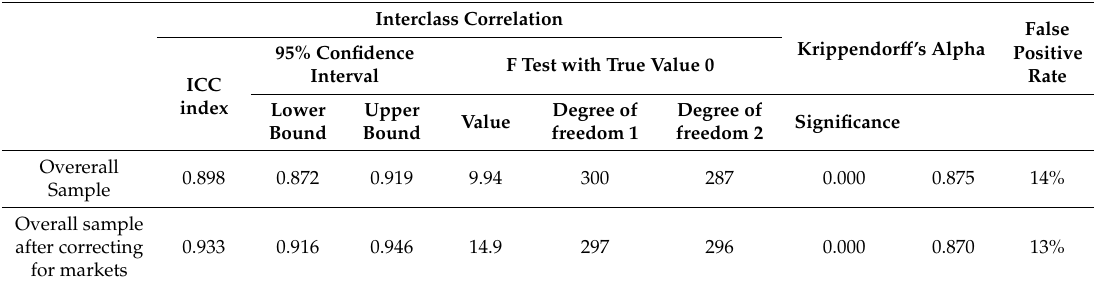
Table 1. Intra-class correlation coe ffi cients (ICCs) calculated using a mean-rating (k = 2), absolute-agreement, two-way mixed-e ff ects model. df, degrees of freedom.